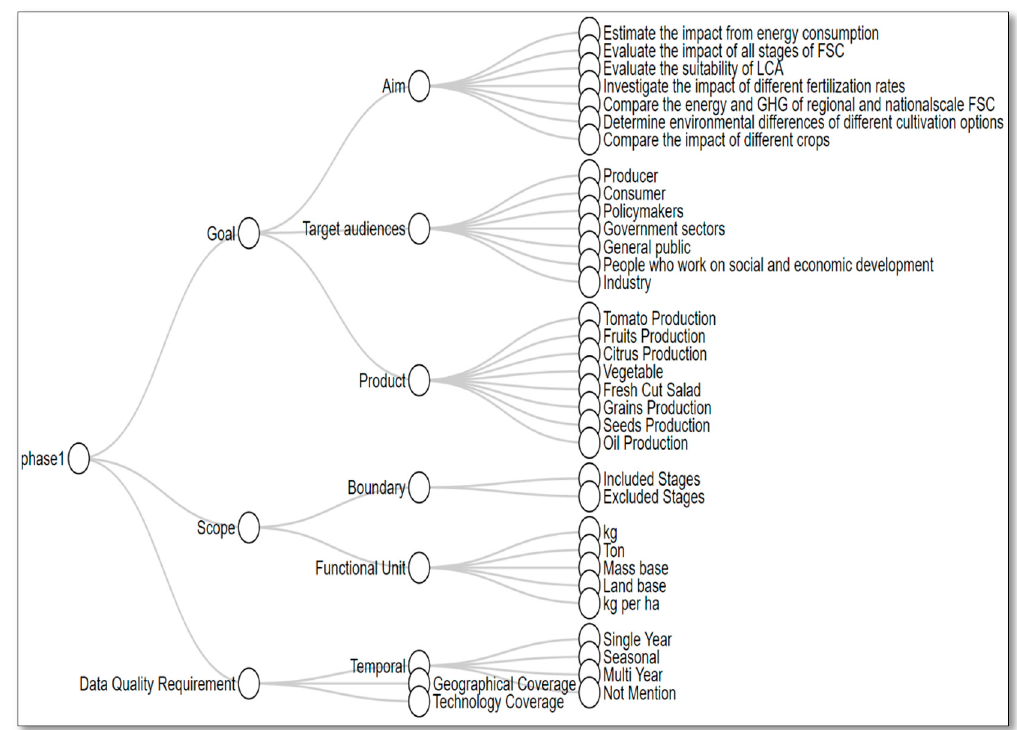
Figure 4. Phase 1 (goal and scope definition) of life cycle assessment (LCA). Target Audience